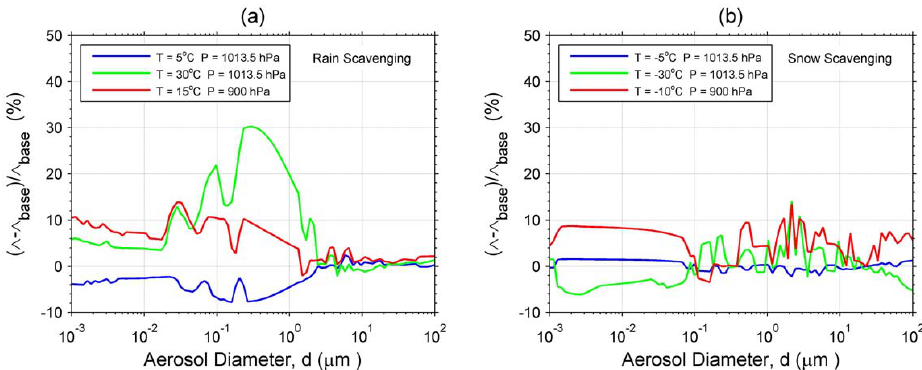
Fig. 8. Percentage differences in 3 from the use of different temperature and pressure values for (a) rain and (b) snow scavenging versus base case. A precipitation intensity of 1.0mmh − 1 was assumed, and the base case refers to the ambient conditions used to develop the new 3 parameterization (i.e., p = 1013 . 25hPa; T = 15 ◦ C for rain scavenging and T = − 10 ◦ C for snow